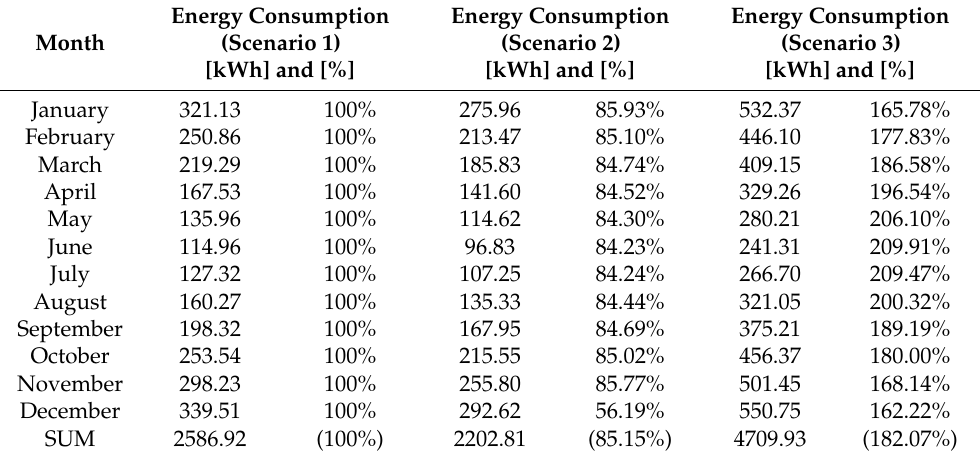
Table 10. Energy consumption for 1 km of lighting installation and various lighting control